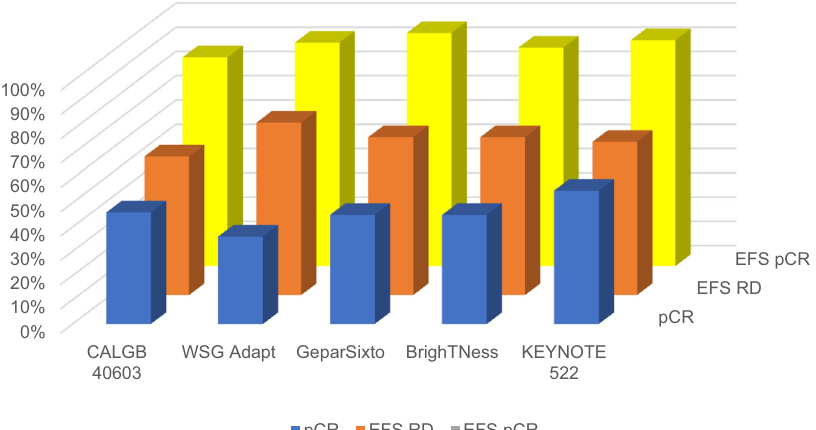
Fig. 4 Relationship of pCR and RD with EFS in TNBC. pCR pathological complete response; RD residual disease; EFS event-free survival; TNBC triple negative breast cancer.